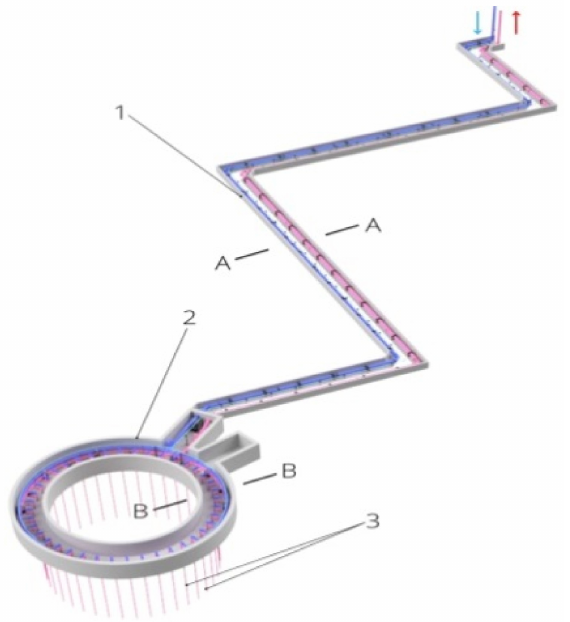
Figure 6. Secondary system of the freezing installation: 1—freezing channel, 2—freezing ring, 3—freezing boreholes.